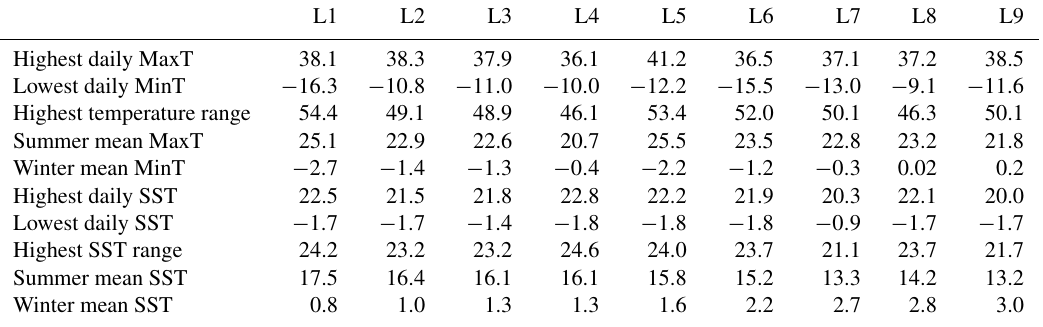
Table 2. Summary values of daily MaxT, MinT, and SST ( ◦ C) for the nine wave-exposed intertidal locations (L1 to L9, from north to south) surveyed between 2014 and 2019 along the Atlantic Canadian coast (see Methods for details on how each row of values was determined). L1 L2